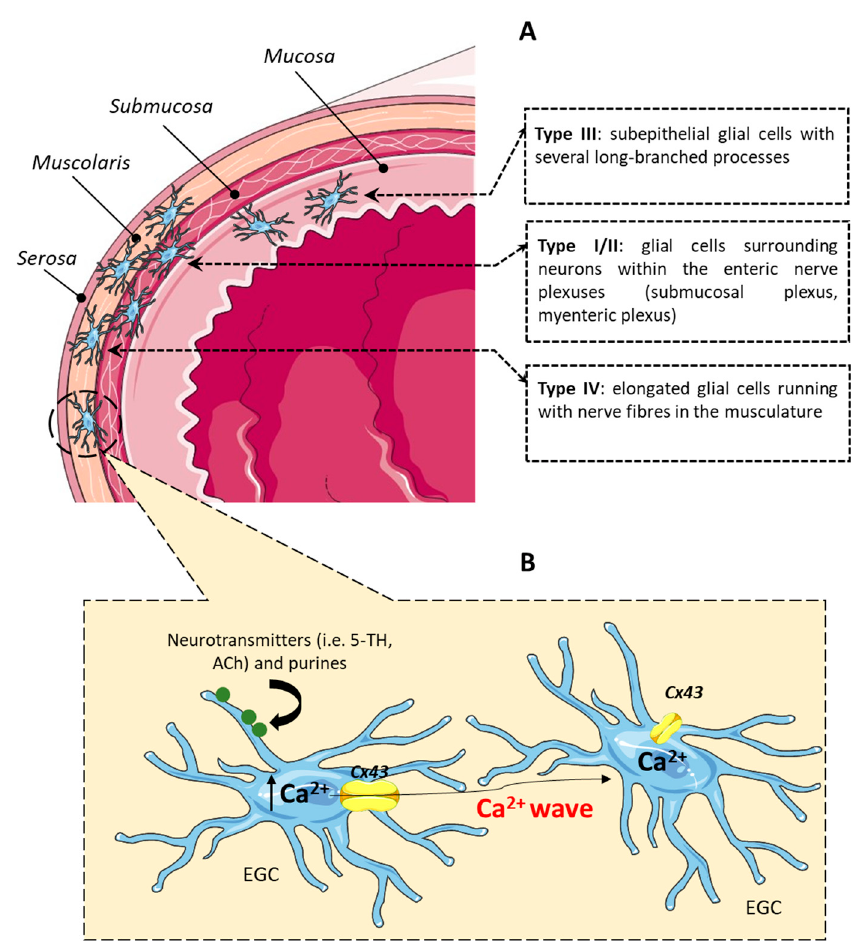
Figure 1. Schematic representation of the distribution and activation of EGCs . ( A ) Type III glial cells are located directly beneath the epithelial cells; type I/II glial cells surround neurons within the enteric nerve plexuses (submucosal plexus and myenteric plexus); type IV glial cells running with nerve fibers in the musculature. ( B ) Neurotransmitters or purines, released from enteric neurons, can activate EGCs, triggering an increase in intracellular Ca 2+ concentration with consequent opening of Cx43 hemichannels. EGCs use Ca 2+ signaling to communicate with each other and transmit information to distant sites within the ENS. Abbreviations: Ca 2+ , calcium; Cx43, connexin-43; EGC, enteric glial cell; ENS, enteric nervous system; 5-HT, serotonin; ACh, acetylcholine.